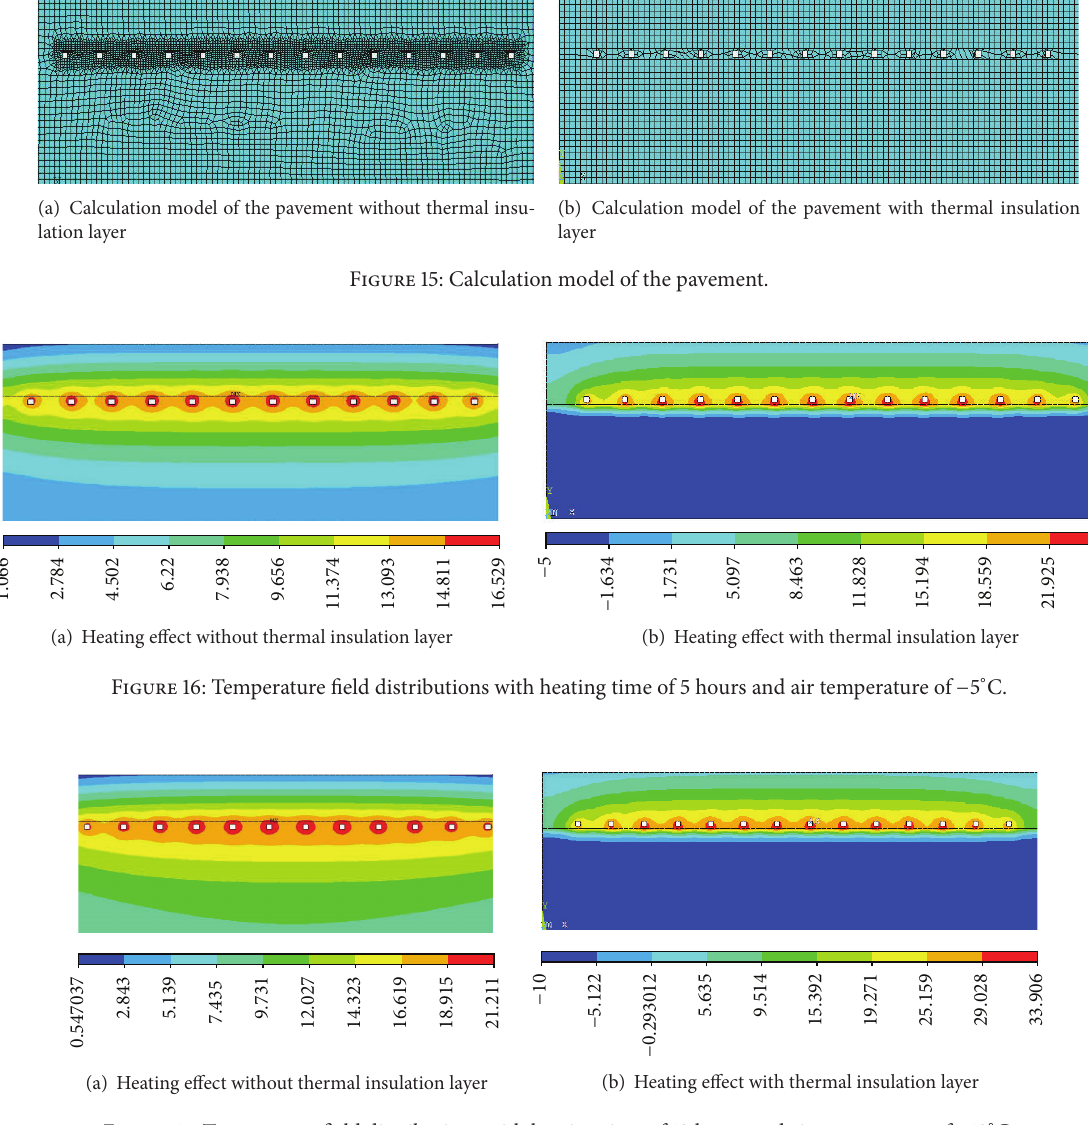
Figure 17: Temperature field distributions with heating time of 10 hours and air temperature of − 10 ∘